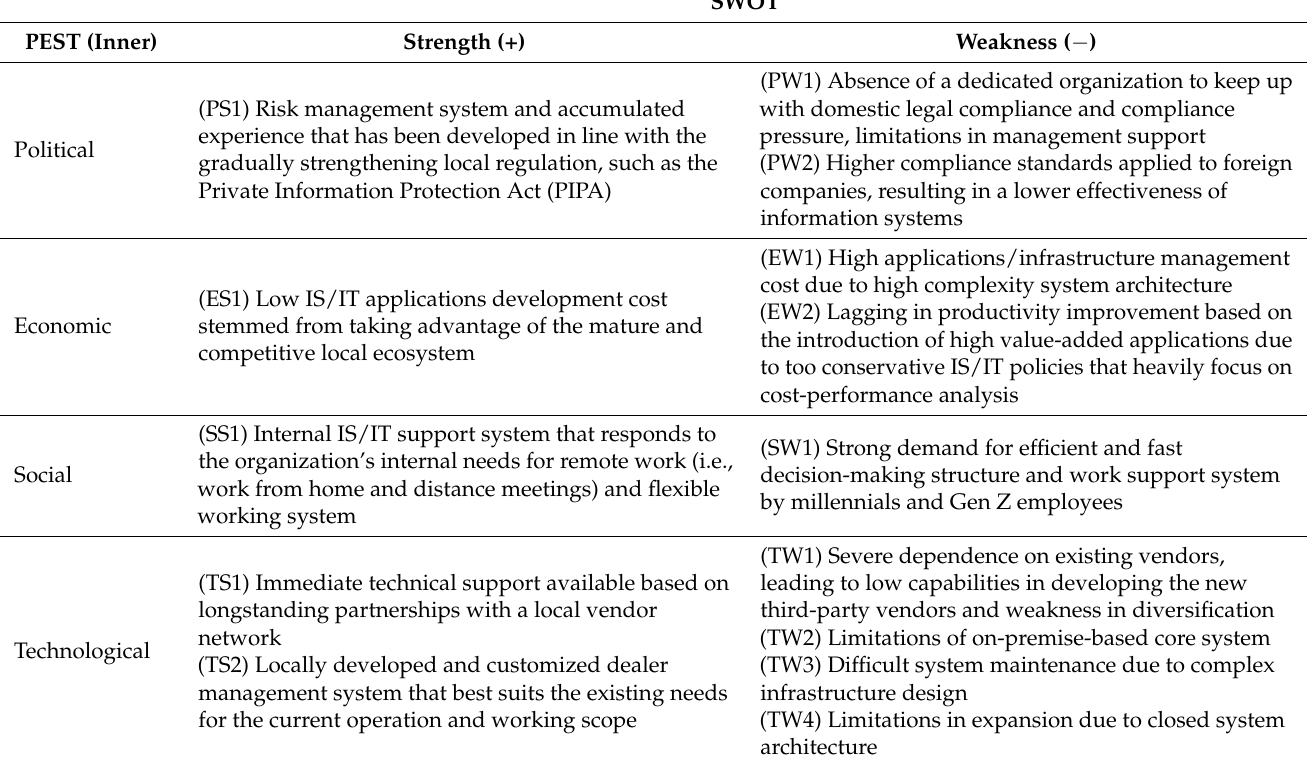
Table 2. PEST-SWOT analysis